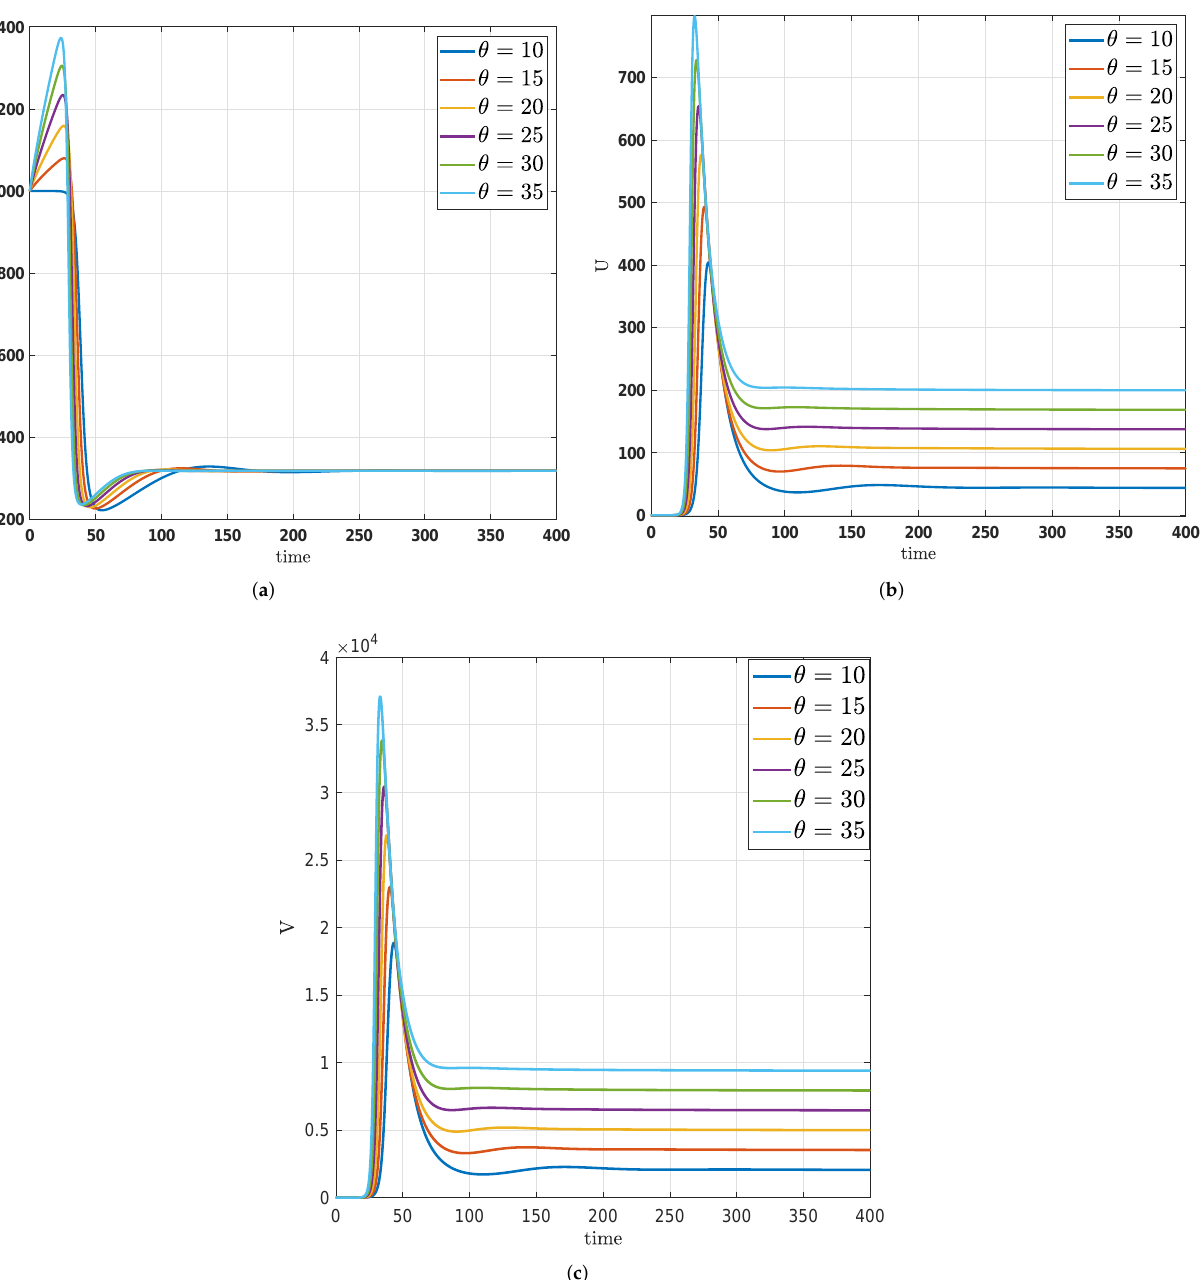
Figure 6. Numerical trajectories by varying the supply rate for new T-cells θ under the fractal order and fractional order δ = σ = 0.95 via the Adams-Bashforth method. ( a ) The effects of θ on T . ( b ) The effects of θ on U . ( c ) The effects of θ on V